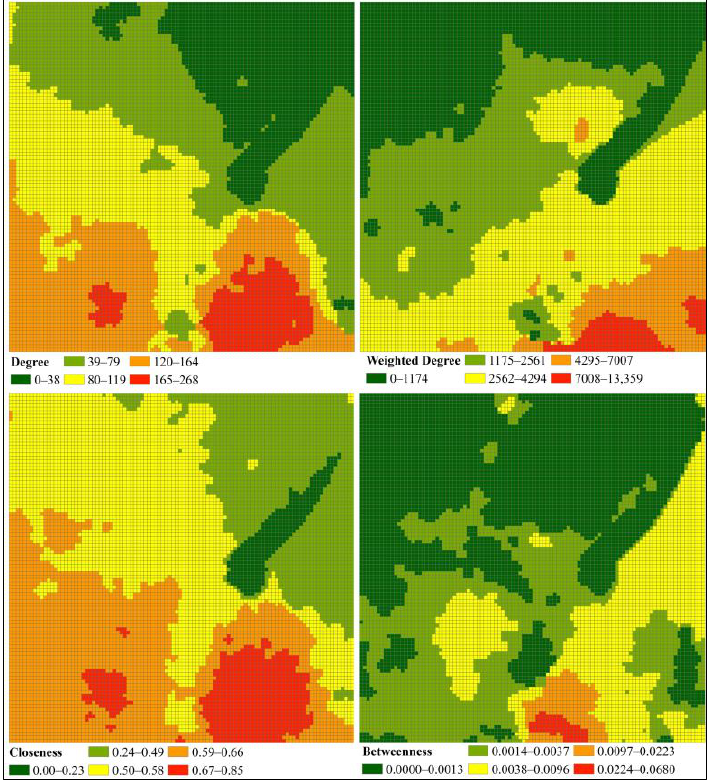
Figure 5. Output panel of the network